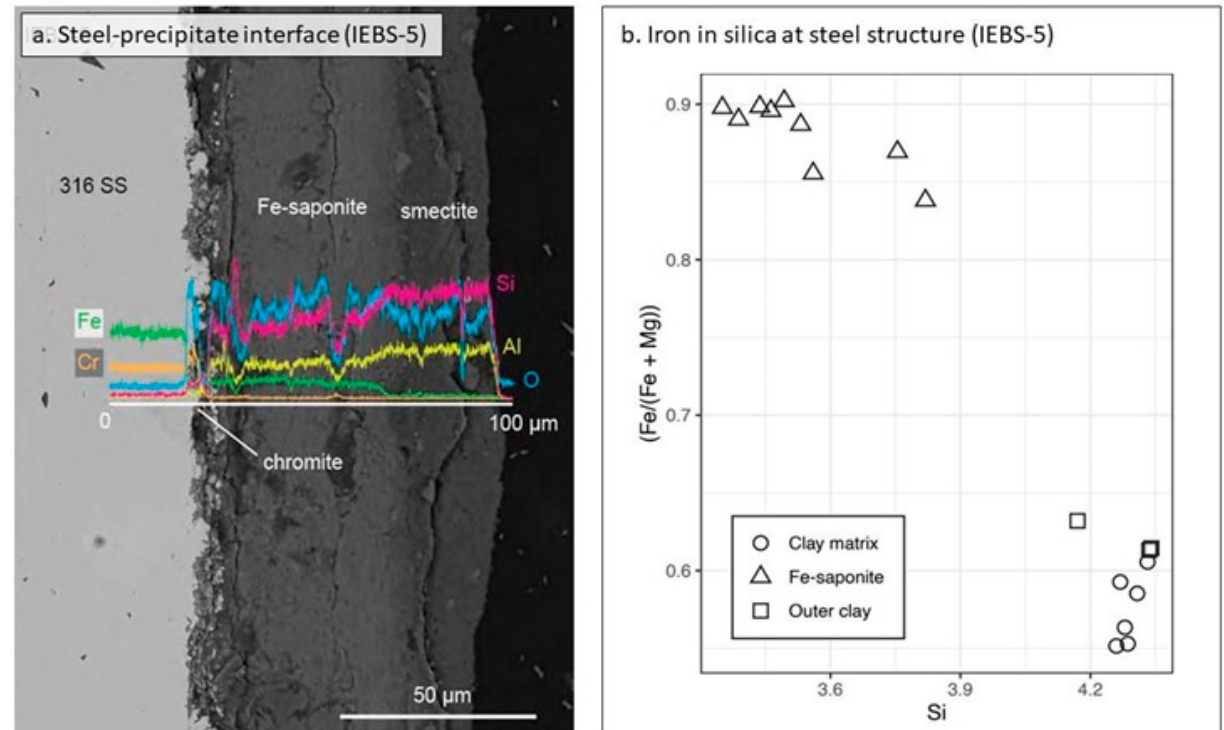
Figure 4. Alteration at the steel-secondary mineral interface. ( a ) Energy dispersive X-ray spectroscopy (EDS) chemical results from a line scan (white line) across the steel-clay boundary from IEBS-5 (GG + WB + 316 SS). Relative elemental abundances of Fe, Cr, Si, Al, and O are identified by color and label. ( b ) Selected EMP results from clay at the steel surface from IEBS-5. Outer clay refers to the clay outboard of the Fe-enriched zone on the steel coupon (labeled as smectite in ( a )). Clay matrix refers to the composition of the clay matrix that makes up the reaction products not attached to the steel.